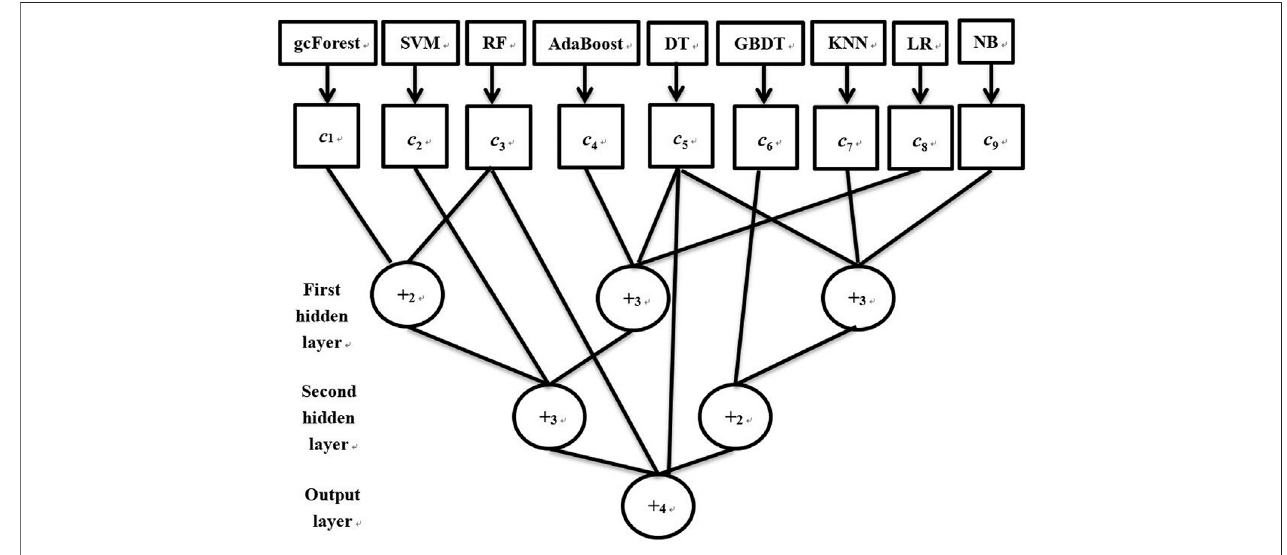
FIGURE 2 | The fl owchart of our proposed ensemble method.